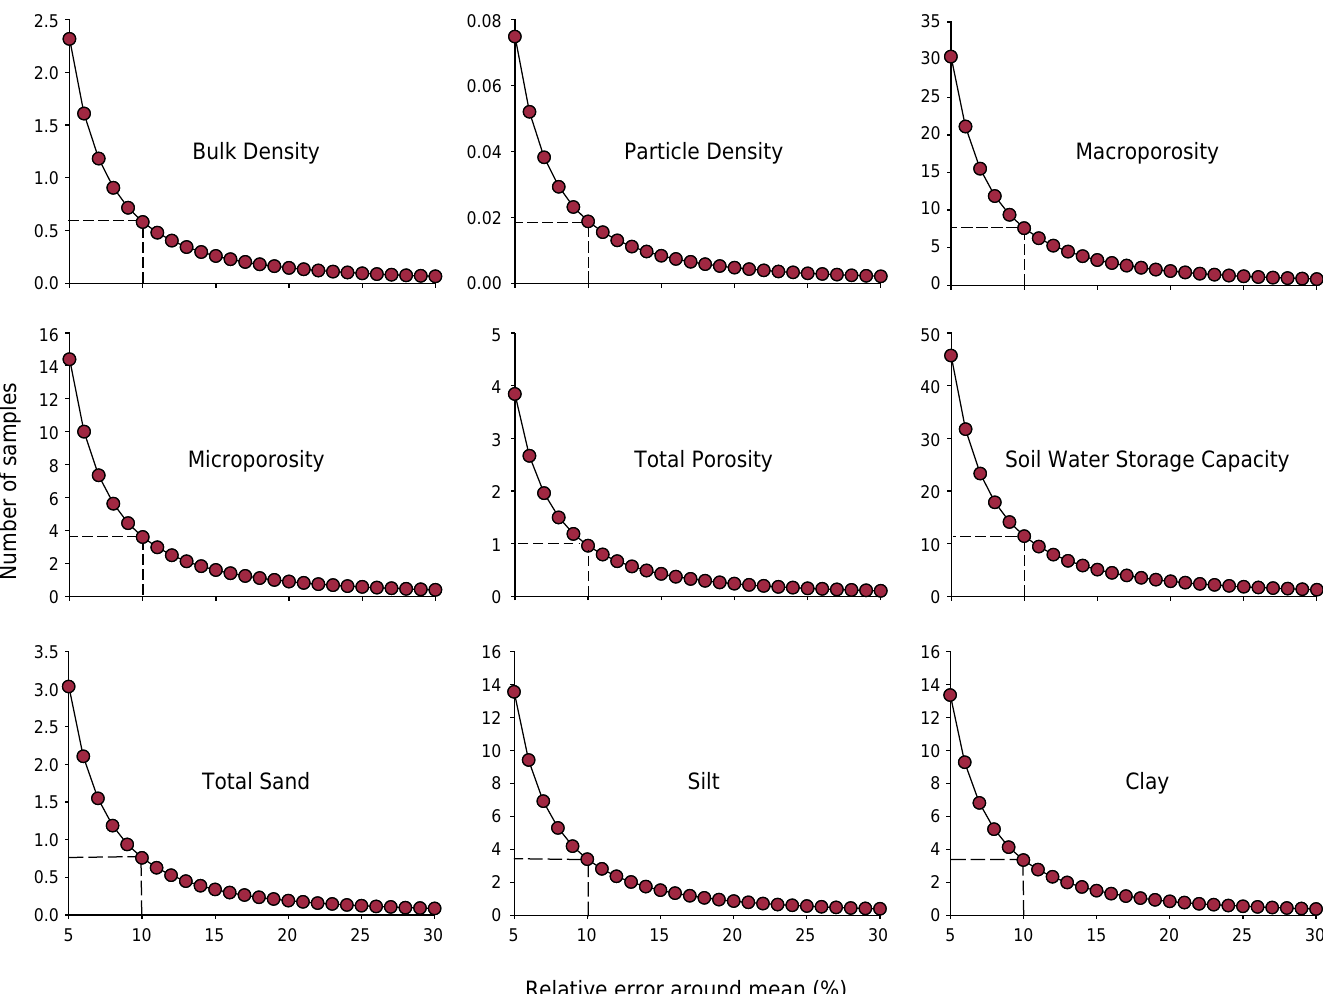
Figure 2. Number of sampling points for estimation of soil density, particle density, soil macroporosity and microporosity, total porosity, soil water storage capacity, total sand, silt, and clay, according to the relative error from the mean, at 5 %